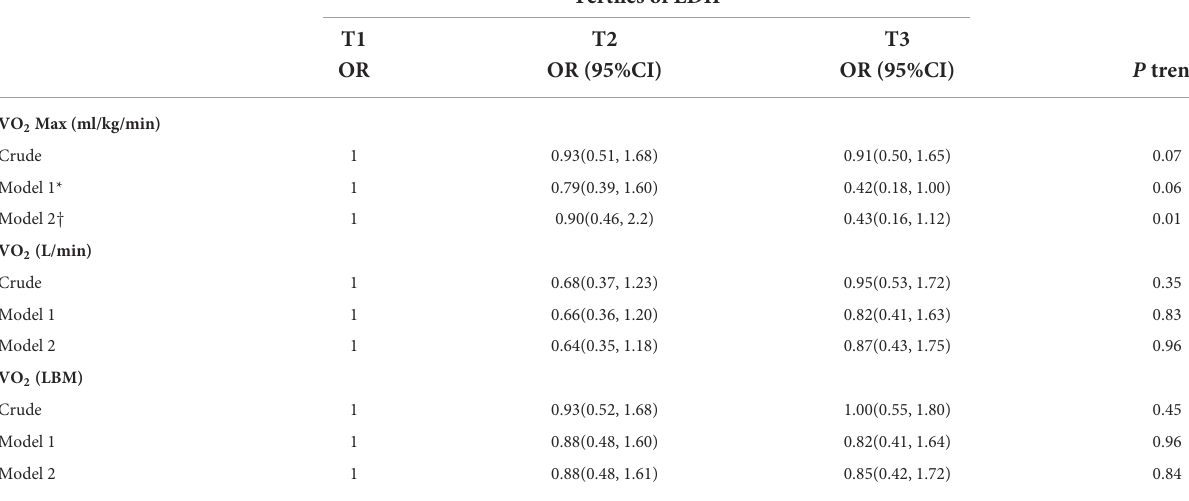
P 1 derivedfromOne-wayanalysisofvariance. P 2 derivedfrompolynomialregressiontest. P 3 derivedfromanalysisofcovariance. SubjectsinthefirsttertileofDIIhadDIIscorebetween( − 1.32,4.23);secondtertile:between(4.24,6.82);thirdtertile:between(6.83,27.0). EDII,empiricallydietaryinflammatoryindex;CRF,cardiorespiratoryfitness. P ANCOVA ,Adjustedforage,sex,smoking,physicalactivity;CVD,respiratorydisease,BMIandenergyintake. TABLE 4 Odds ratios (ORs) and 95% confidence intervals (95% CIs) for CRF according to tertiles of